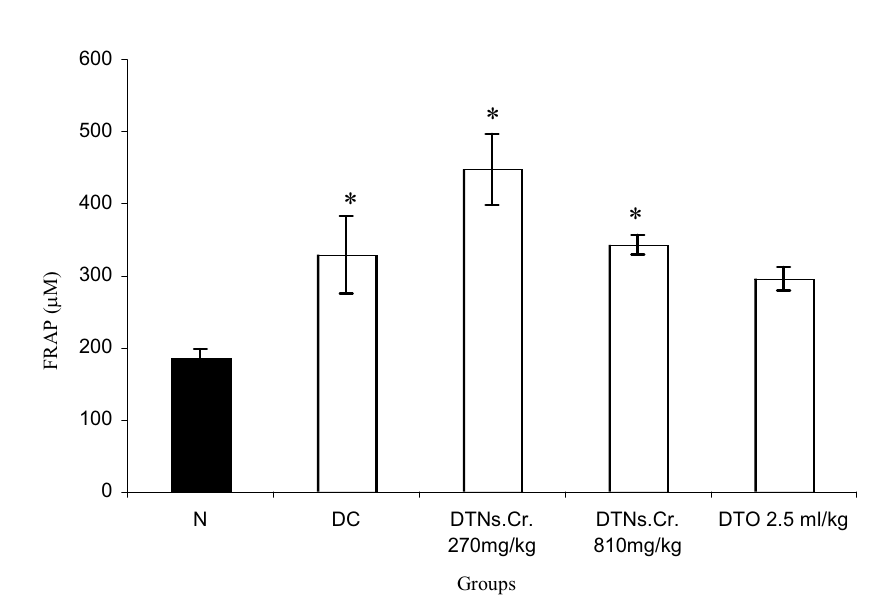
Figure 3. Total plasma antioxidant capacity. N, normal rats group (n=5); DC, diabetic control rats group (n=5); DTNs.Cr, N. sativa crude extract treated diabetic rats group (n=5); DTO, oil treated diabetic group (n=5). Values are expressed as mean ± SEM. *Significantly different from N-rats group by ANOVA test, p <